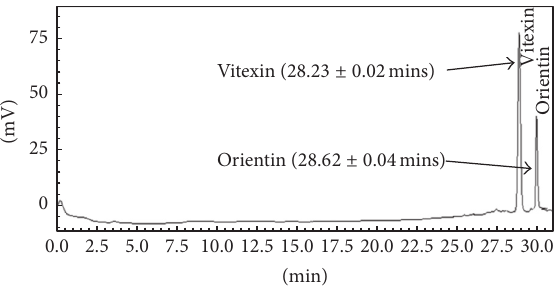
Figure 5: HPLC-UV/DAD chromatogram profile of both flavonoids compounds (vitexin and